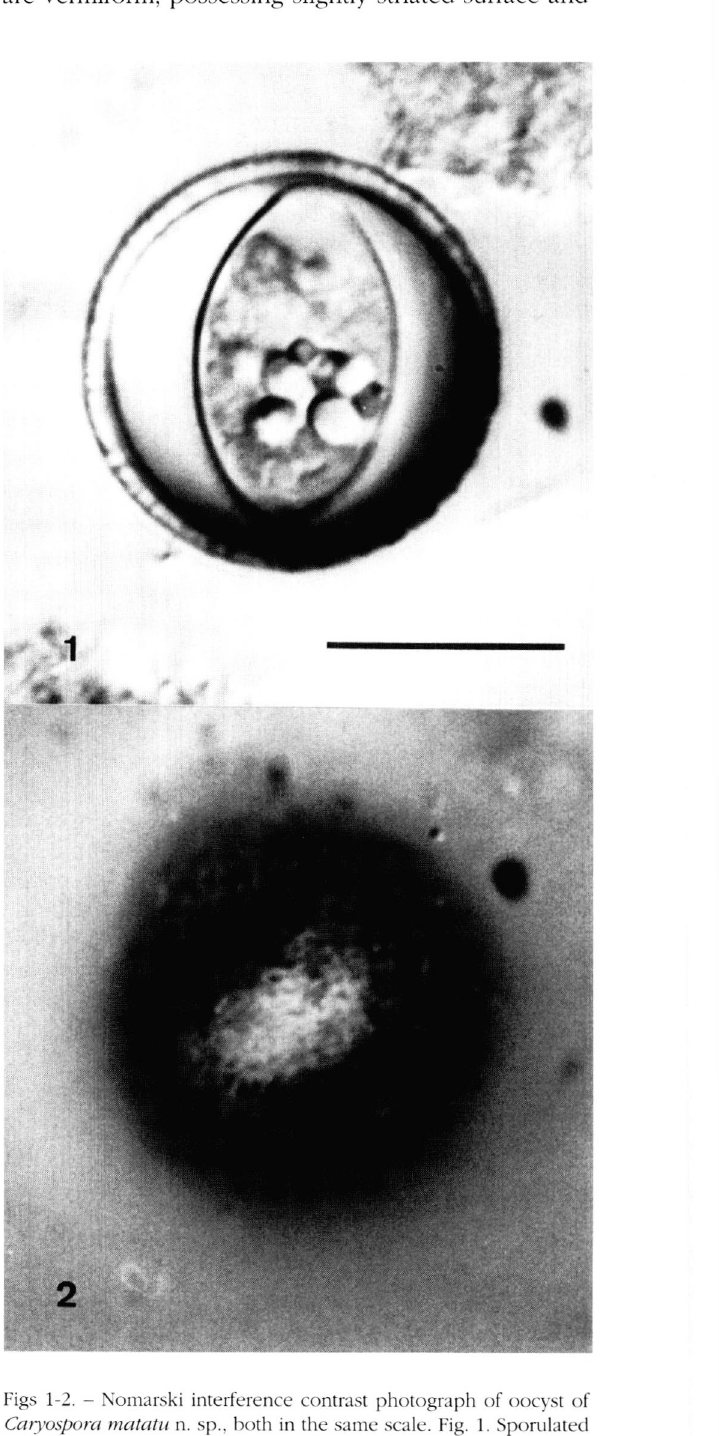
Figs 1-2. - Nomarski interference contrast photograph of oocyst of Caryospora matatu n. sp., both in the same scale. Fig. 1. Spomlated oocyst. Scale bar = 10 um. Fig. 2. Surface of the oocyst wall sho­ wing distinct